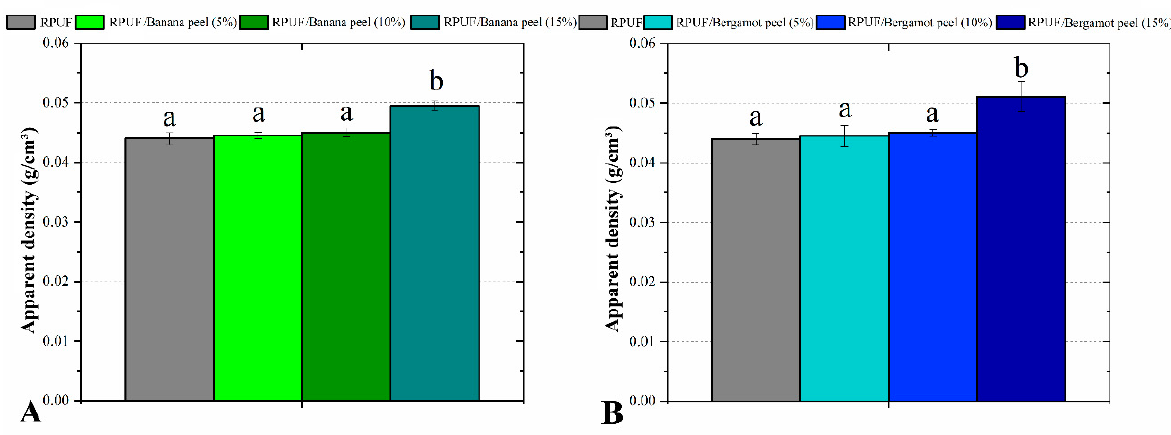
Figure 6. Apparent density of the studied RPUF with Banana peels ( A ) and Bergamot peels ( B ). RPUF is the neat rigid polyurethane foam and filler type, and filler content is the numbers after the bars and between parentheses, respectively. Different letters represent statistically different means.